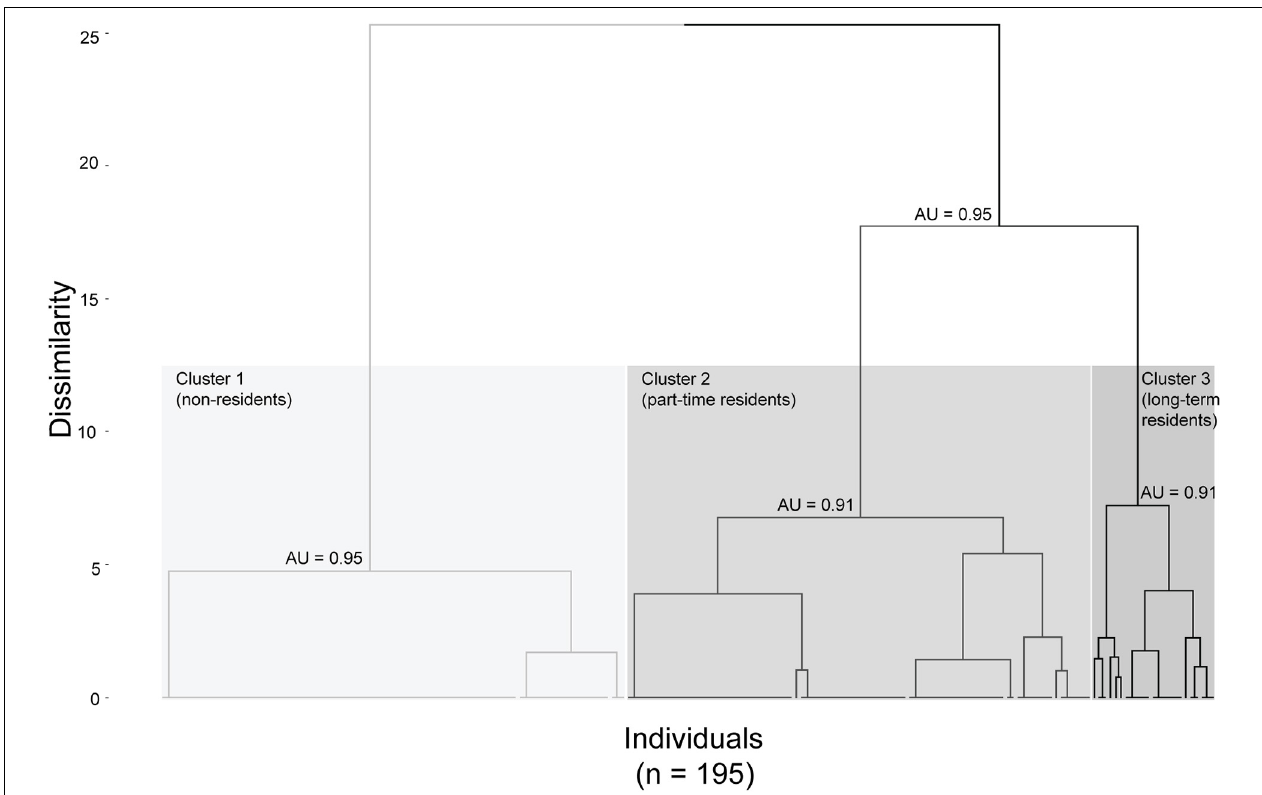
FIGURE 4 | Agglomerative hierarchical clustering (AHC) dendrogram of snubfin dolphins in Yawuru Nagulagun based on monthly and yearly sighting rates. The rectangles (dissimilarity threshold = 12.5) indicate three clusters with cluster 1 (“non-residents”) with 85 individuals (43.59% of the population), cluster 2 (“part-time residents”) with 87 individuals (44.62% of the population) and cluster 3 (“long-term residents”) with 23 individuals (11.79% of the population). The approximately unbiased (AU) probability values of these three clusters are shown in the